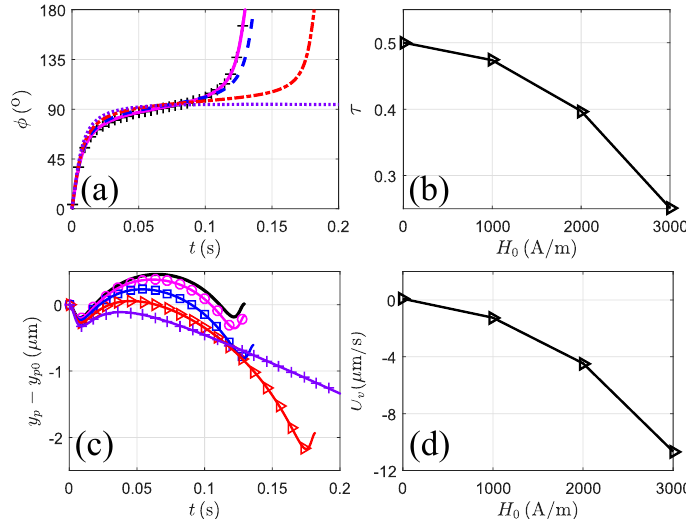
Figure 9. The effect of magnetic field strength on particle transport, with AR = 4, y p 0 = 12 µ m, and α = 90 ◦ . ( a ) φ versus t over a period for H 0 = 0 (plus symbol), 1000 A/m (solid line), 2000 A/m (dash line), 3000 A/m (dash-dot) and 4000 A/m (dot); ( b ) τ versus H 0 ; ( c ) the lateral migration of particle y p − y p 0 with time t over a period for H 0 = 0 (solid line), 1000 A/m (circle symbol), 2000 A/m (square symbol), 3000 A/m (triangle symbol) and 4000 A/m (plus symbol); ( d ) the vertical velocity U v versus magnetic field strength H 0